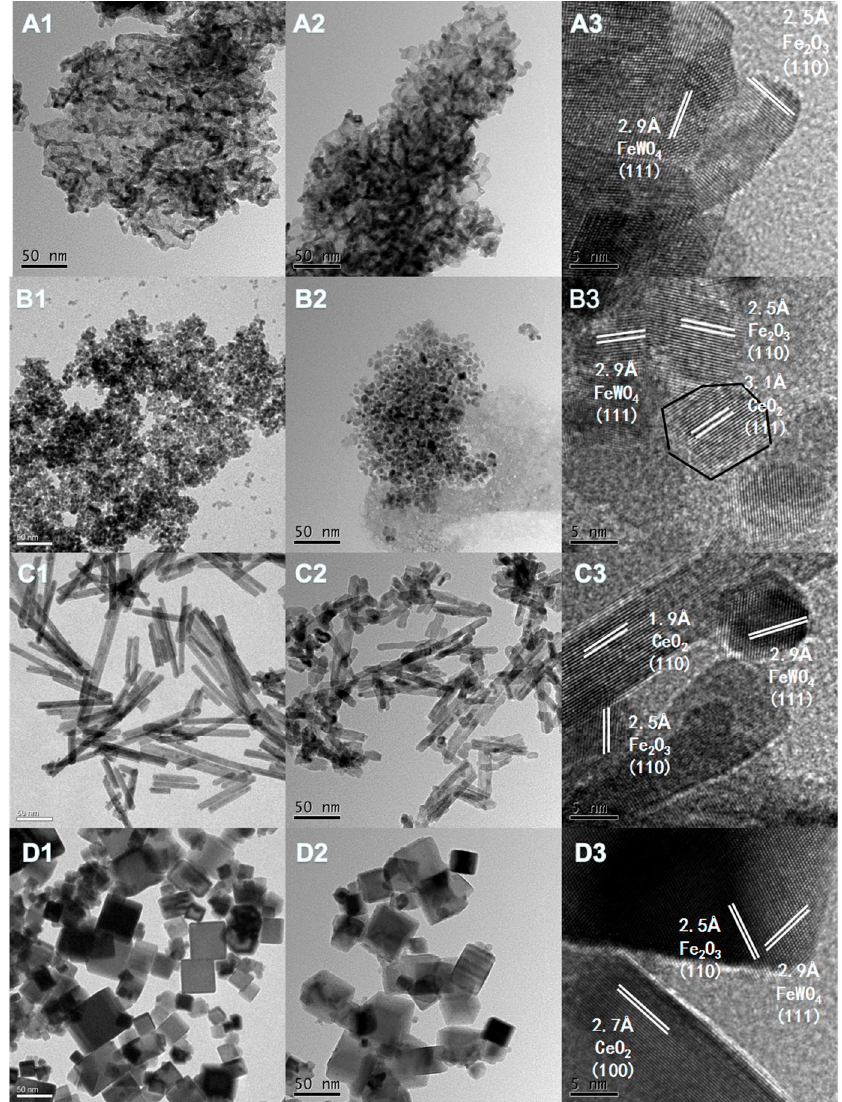
Figure 1. TEM images of ( A1 , B1 , C1 and D1 ) of CeO 2 –O, CeO 2 –P , CeO 2 –R and CeO 2 –C; TEM